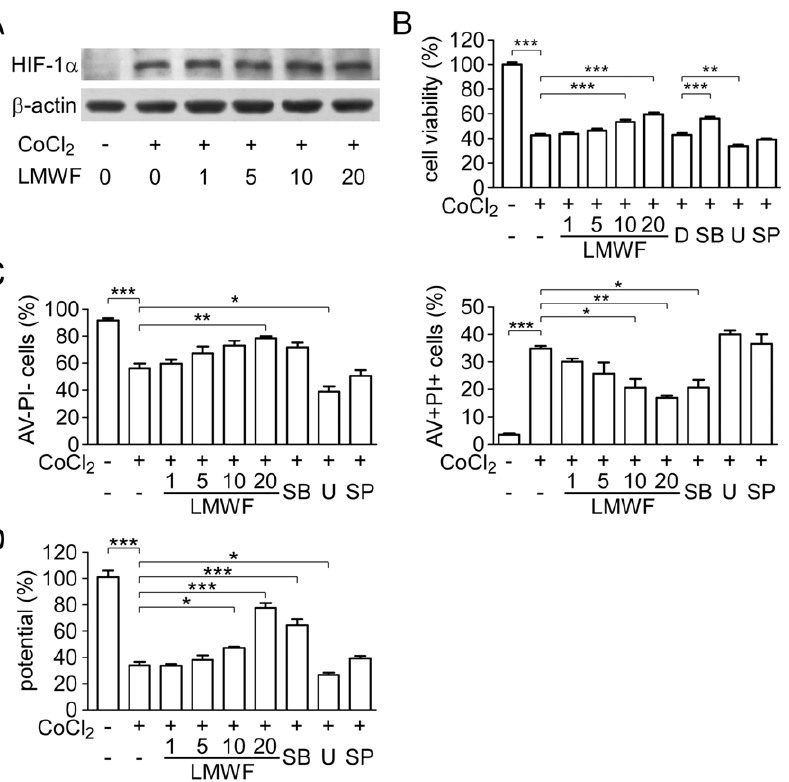
Figure 7. LMWF protected HK2 cells treated with CoCl 2 . Cells were cultured to 70% to 80% confluence, and then were pretreated with 1 , 20 m g/ml LMWF or MAPK inhibitors SB-203580 (SB), U-0126 (U), SP-600125 (SP), at 15 m M, or DMSO (D) as a control for 1 h, and then cells were cultured in serum-free DMEM/F12 with 600 m M CoCl 2 . (A) HIF-1 a protein level in HK2 cells treated with 600 m M CoCl 2 for 3 h were detected by Western blot analysis. Representative blottings are shown. (B) Viability of HK2 cell treated with 600 m M CoCl 2 for 24 h was assayed using CCK-8 kit. (C) Left bar diagram shows the population of live cells. Right bar diagram shows the population of late apoptotic cells. (D) Dissipation of DY m in HK2 cells treated with 600 m M CoCl 2 for 18 h. Bar diagram shows ratio of ‘red’ to ‘green’ fluorescence that represented DY m of cells. Data are mean 6 SEM. n=4. * P , 0.05, ** P , 0.01, *** P , 0.001.